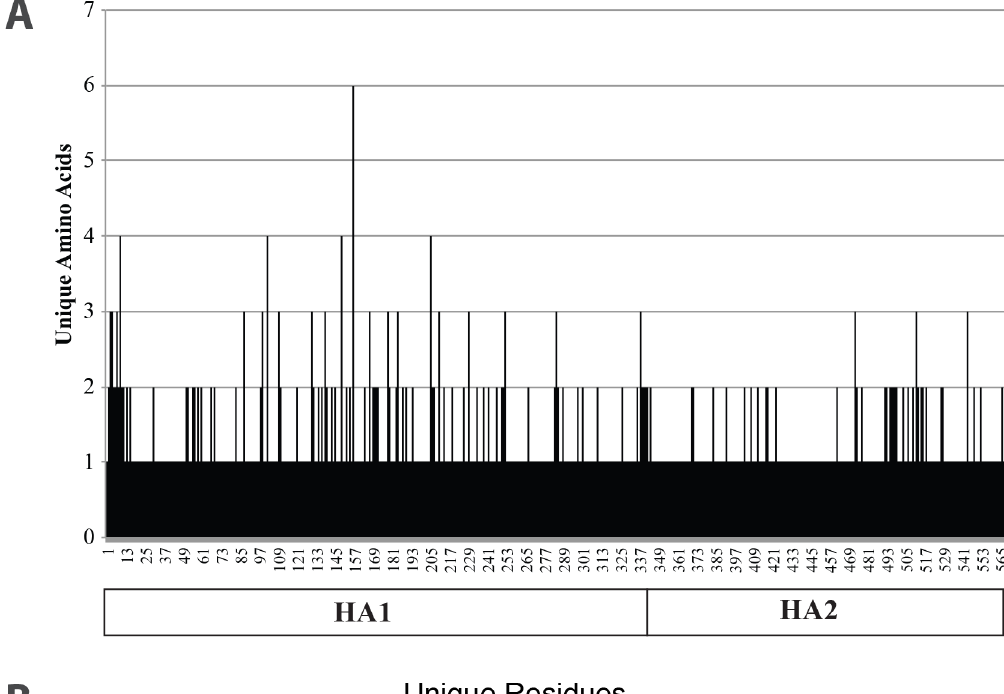
PLOS ONE | DOI:10.1371/journal.pone.0160510 August 5,